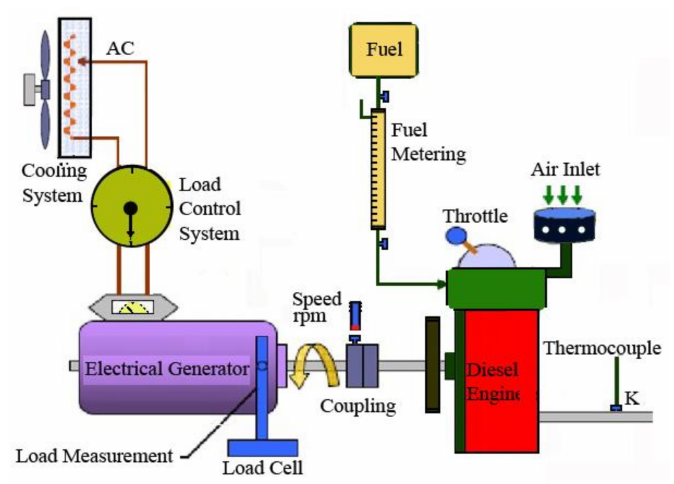
Figure 1. Set-up for the engine